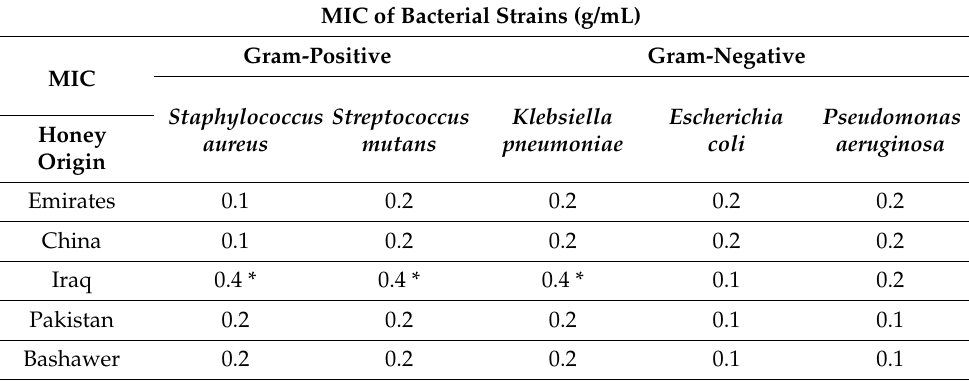
Minimal inhibitory concentration (MIC) of Sidr honey against antibiotic resistant bacterial